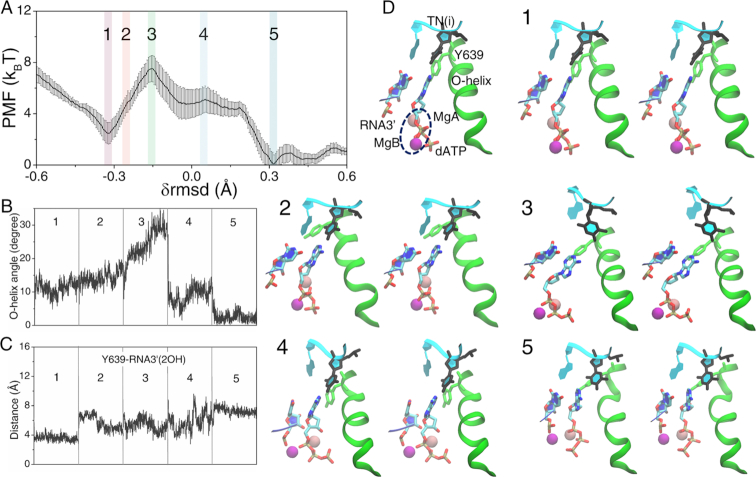
The constructed PMF for the non-cognate dATP bound structure from the pre-insertion on-path to the insertion state and key structure measures. (A) The PMF obtained from the umbrella sampling simulations along the collective reaction coordinate \documentclass[12pt]{minimal}
\usepackage{amsmath}
\usepackage{wasysym}
\usepackage{amsfonts}
\usepackage{amssymb}
\usepackage{amsbsy}
\usepackage{upgreek}
\usepackage{mathrsfs}
\setlength{\oddsidemargin}{-69pt}
\begin{document}
}{}${\rm{\delta rmsd}}$\end{document}. (B) The O-helix angle obtained from the five windows labeled on the PMF curve. (C) The distance distribution between Y639 and RNA3′-2OH. (D) The five representative structures along the reaction coordinate (in stereo views). A pre-insertion configuration (config 1) with TN(i), Y639, O-helix, MgA/B, dATP and RNA 3′ denoted is also shown. The black dashed circle highlights the two magnesium ions (MgA and MgB) that switch roles in stay and leave.